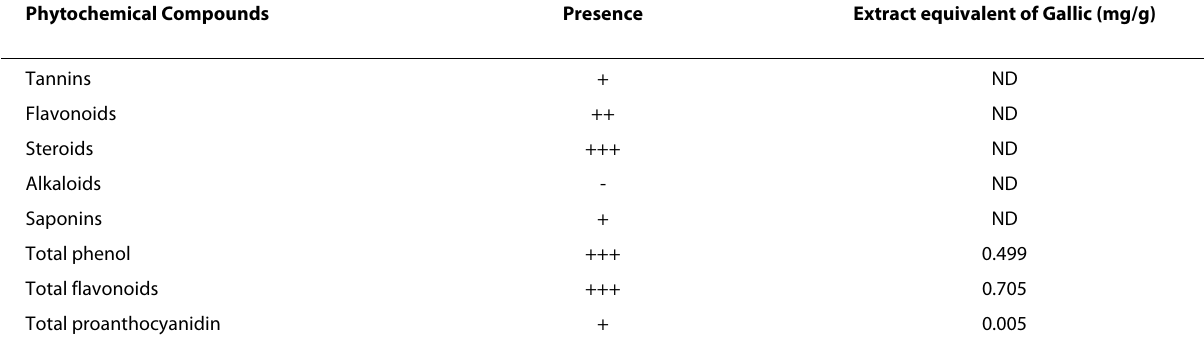
Table 1: The phytochemical components of H. longifolium based on the preliminary aqueous crude leaf extract screening. Phytochemical Compounds